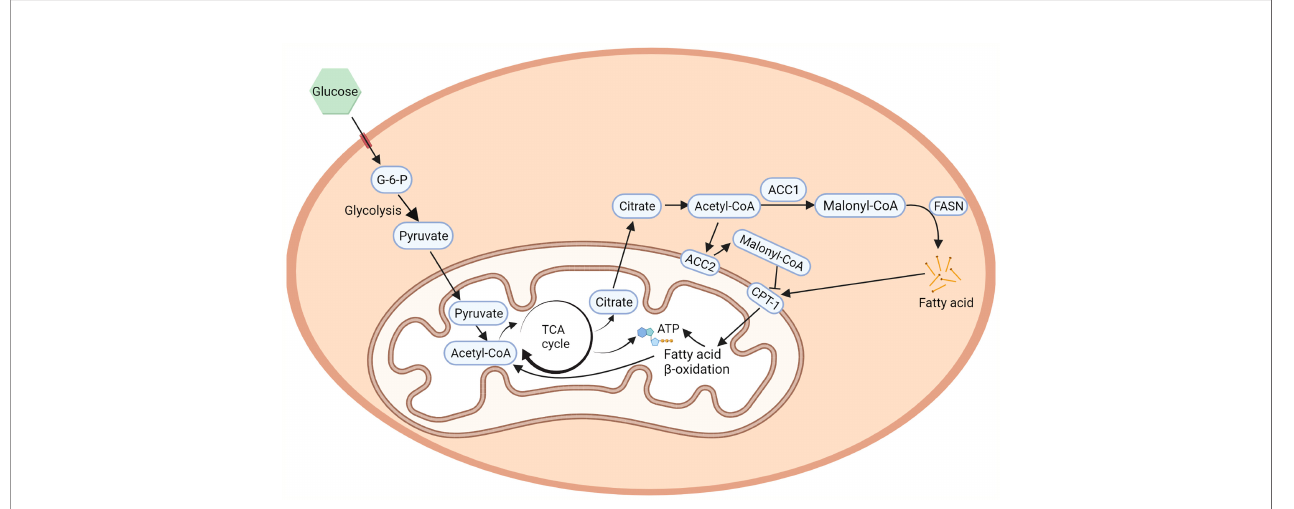
FIGURE 2 | ACCs in fatty acid metabolism. ACC1 is a cytoplasmic protein that catalyzes the conversing of acetyl-CoA to malonyl-CoA in the de novo fatty acid biosynthesis (2). On the other hand, the hydrophobicity of the N-terminal region of ACC2 allows its localization to the outer membrane of the mitochondria, regulates CPT1 which controls fatty acid b -oxidation (25). Created with